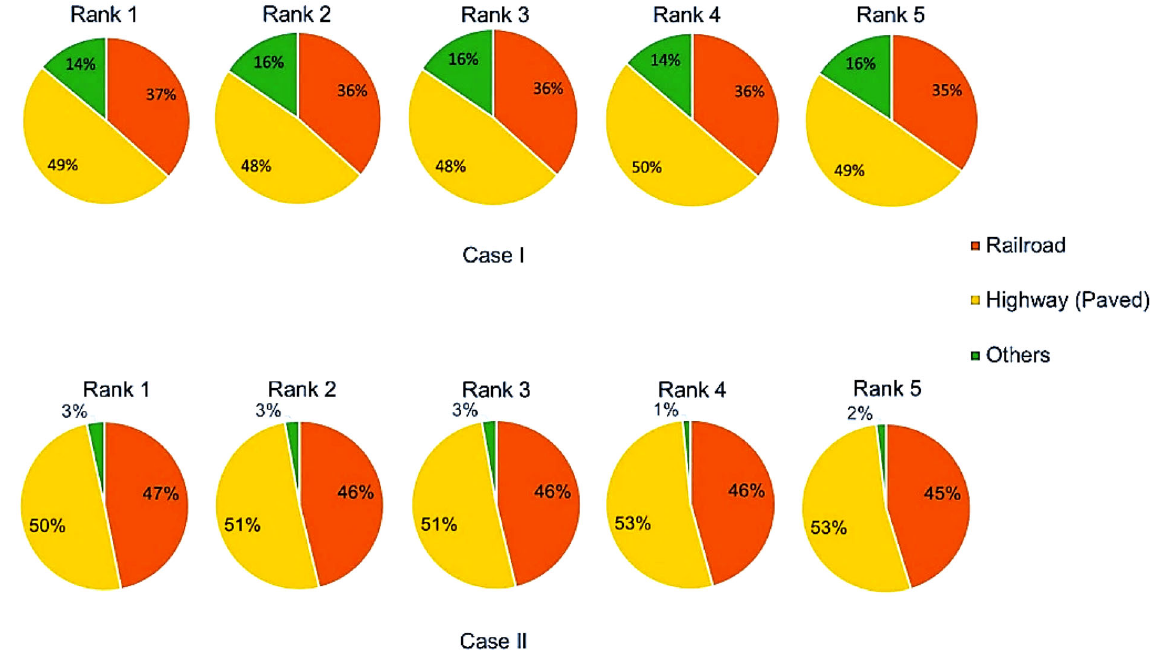
Fig. 10 Distribution of railway and road segment categories for top five most suitable zones in Case I and II